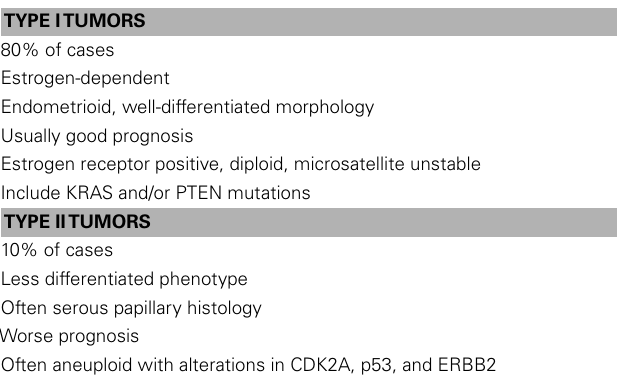
Table 1 | Classification of endometrial cancers